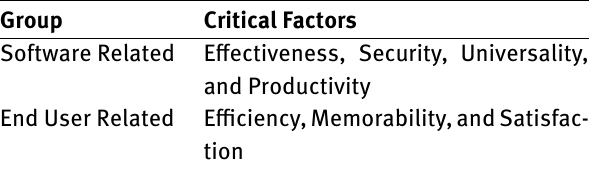
Usability model considers all the inputs (the